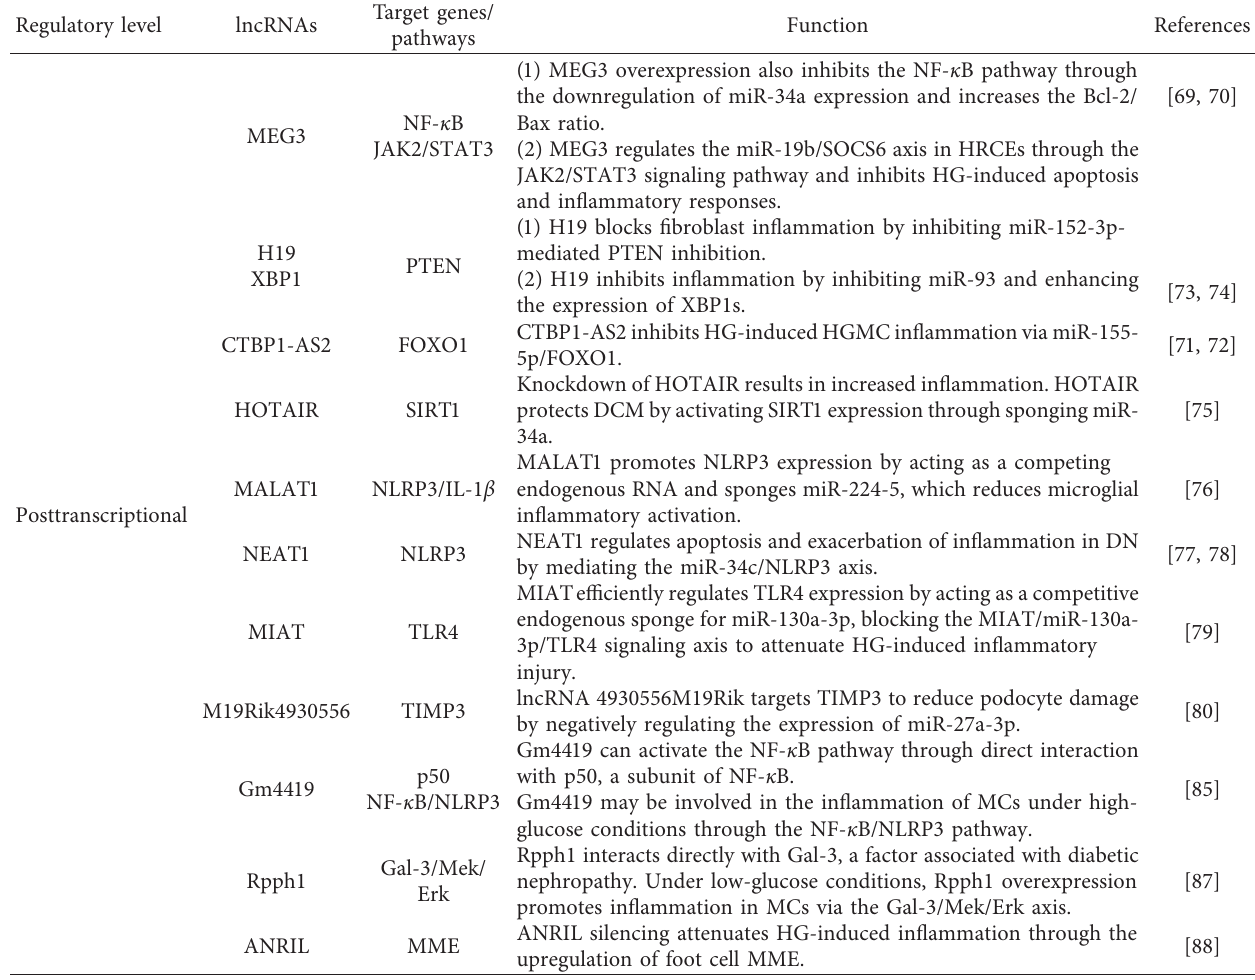
Table 3: The function of lncRNAs at the posttranscriptional